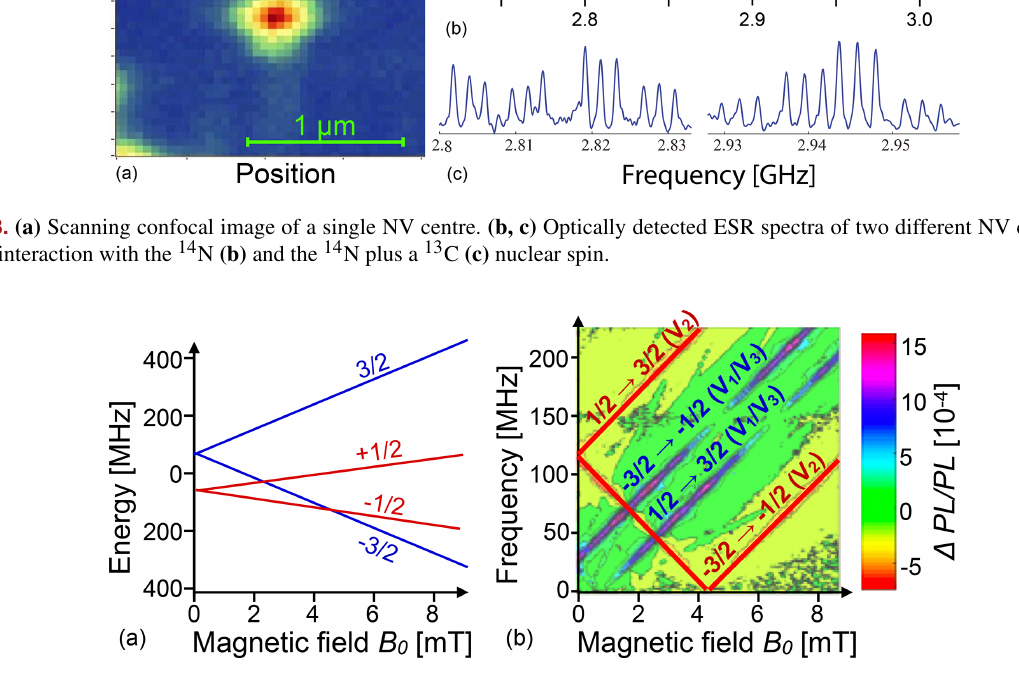
Figure 19. (a) Energy level system of the V 2 Si − vacancy in SiC (6H polytype). (b) Experimental ODMR spectra as a function of the magnetic field (horizontal axis) and RF (vertical axis). The experimental spectrum contains transitions from V 1 and V 3 vacancies. The colour indicates the relative change in PL.